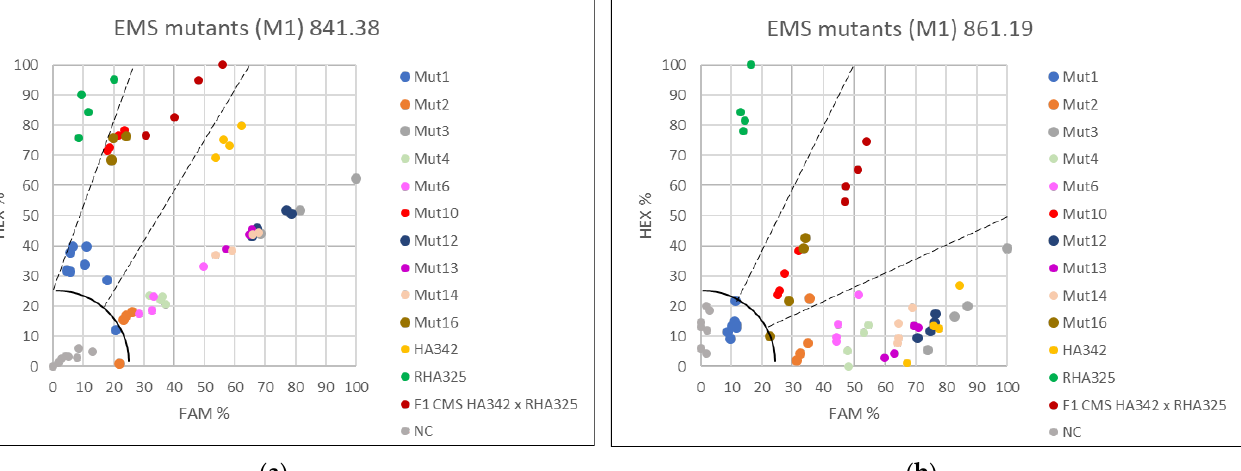
Figure 7. Investigation of the restorer locus Rf1 in EMS-treated plants (M1 generation) by application of two KASP markers. ( a ) Screening with KASP 841.38 and ( b ) Screening with KASP 861.19. The KASP assays showed that only the partially male-sterile Mut1 and the male-fertile EMS-branching mutant Mut16 proved to be F1 hybrids, whereas Mut10 represents a male-sterile recombinant plant, where a recombination event had occurred in the region between HanXRQr2_Chr13g0608631 (PPR621) and the two other genes HanXRQr2_Chr13g0609921 (PPR841) and HanXRQr2_Chr13g0609901 (PPR861) (Figure 8).